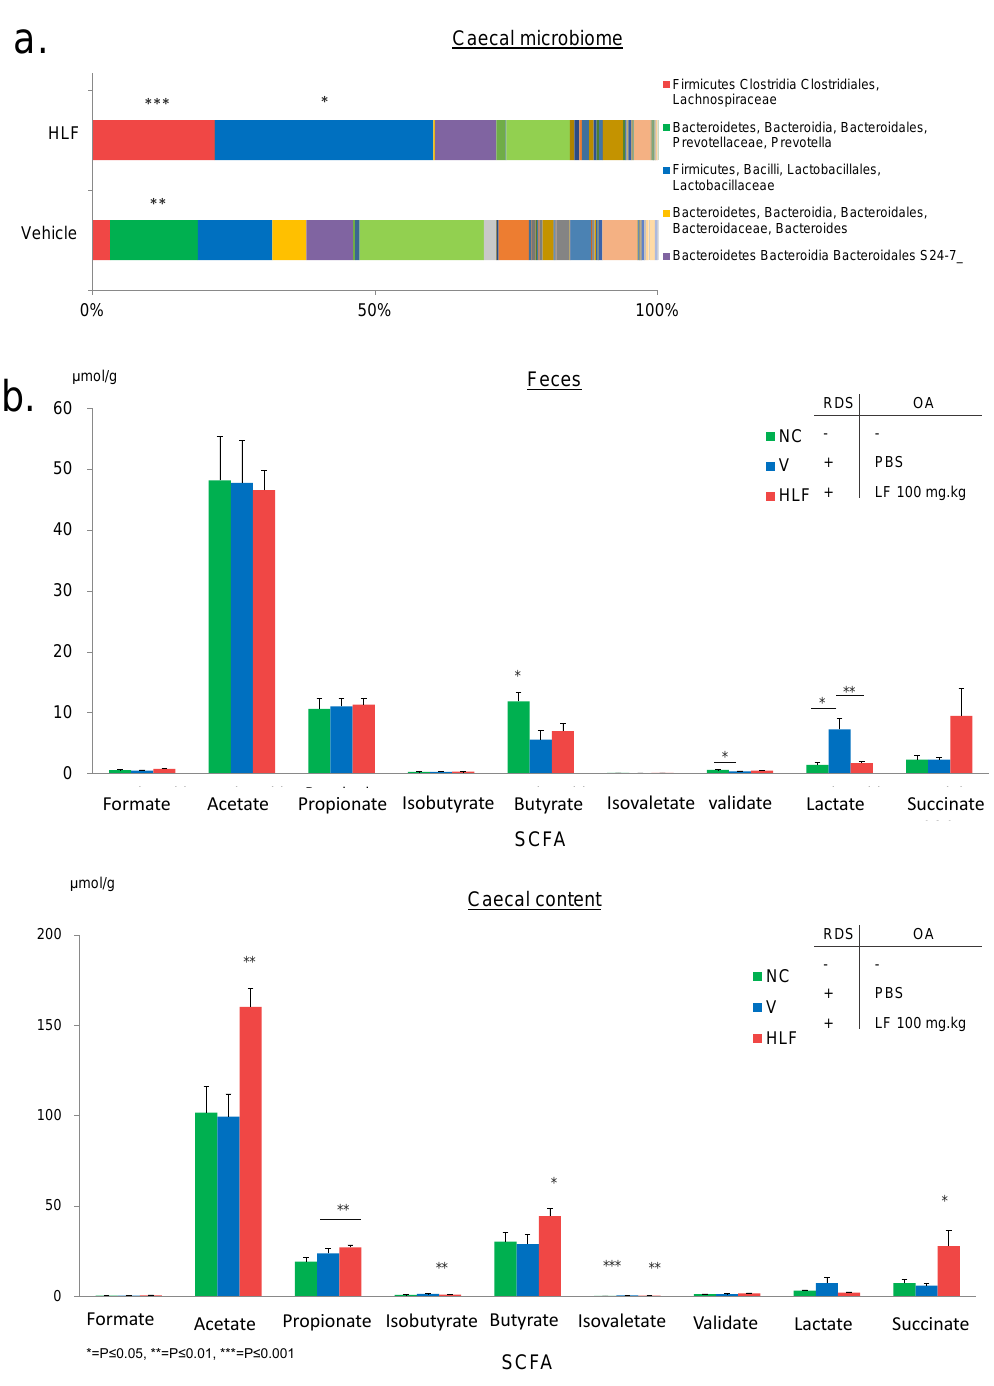
Figure 3. Analysis of the gut microbiome and SCFA composition. ( a ) Next generation sequencing of bacterial genomic DNA from caecal samples of HLF and V mice. Significant increases in a number of commensal bacteria implicated in the production of SCFA were observed in HLF mice. ( b ) Gas chromatography–mass spectrometer analysis of various SCFA and organic acid concentrations in faecal and caecal samples. A significant increase in acetate, propionate, butyrate, isovalerate, and succinate was observed in the caecal content samples of HLF mice relative to V mice. In faecal samples, only butyric acid concentration was significantly higher in NC mice relative to the other groups. A significant difference was observed in valeic acid concentrations between NC and V mice. No significant difference was observed for the remaining SCFA in faecal